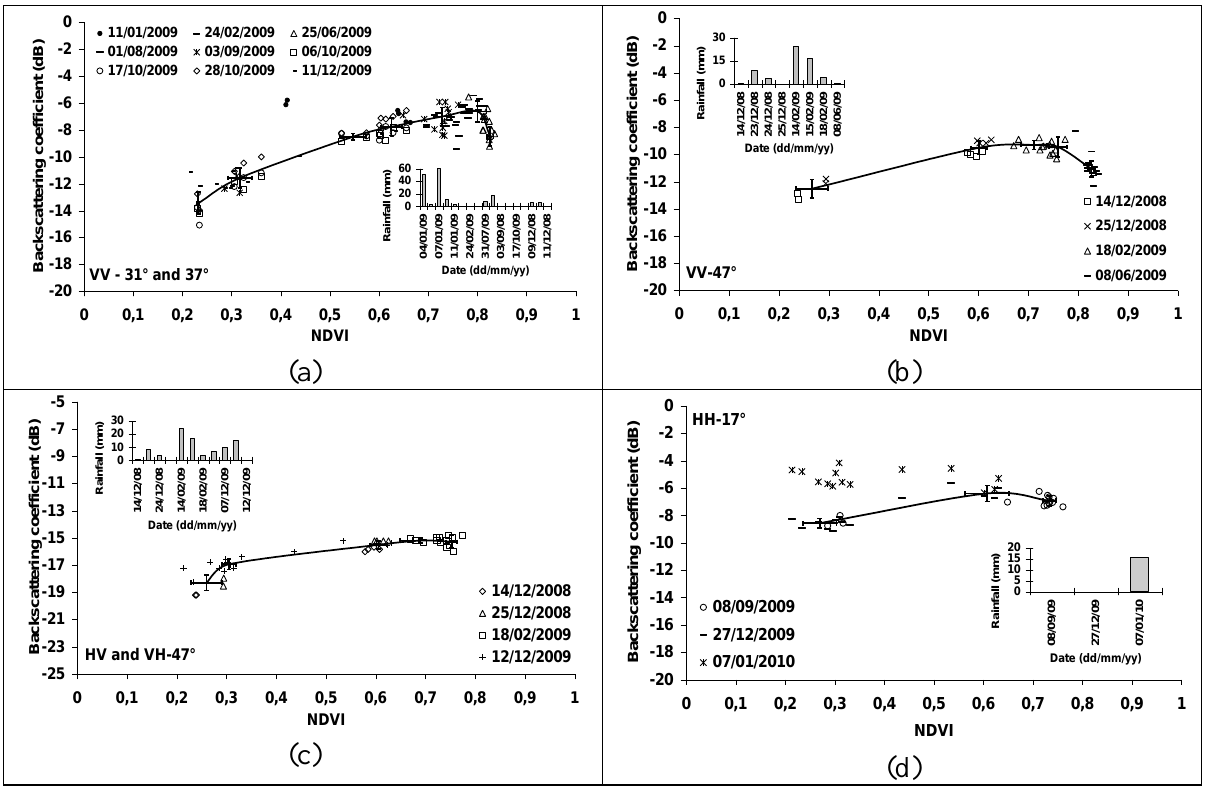
Figure 7. Sensitivity of backscattering coefficient to NDVI. (a) VV-31° and